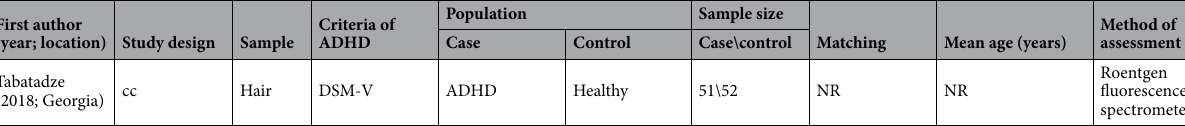
Table 1. Baseline characteristic of included studies. BMI body mass index, CC case–control, CS cross- sectional, Zn zinc, ADHD attention deficit hyperactivity disorder.